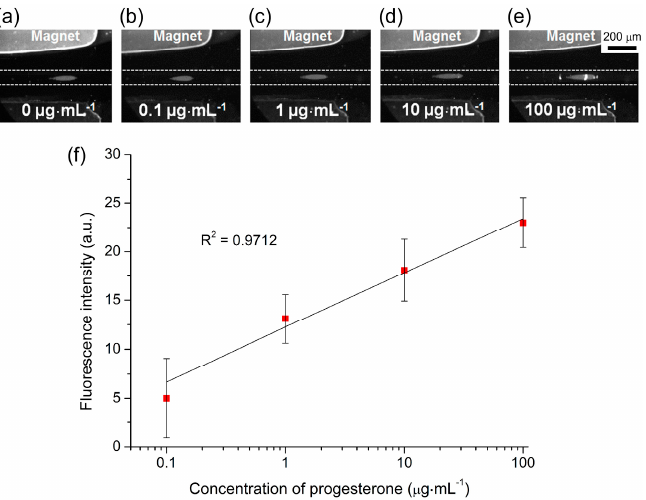
Figure 8. Results obtained for a progesterone (P4) assay, achieved by flushing P4-FITC over a trapped plug of anti-P4 functionalised magnetic particles. ( a – e ). Fluorescence images of particle plugs with increasing P4-FITC concentrations. ( f ) Plot of background-corrected particle plug fluorescence intensities at different concentrations (shown on a logarithmic scale) of P4-FITC.